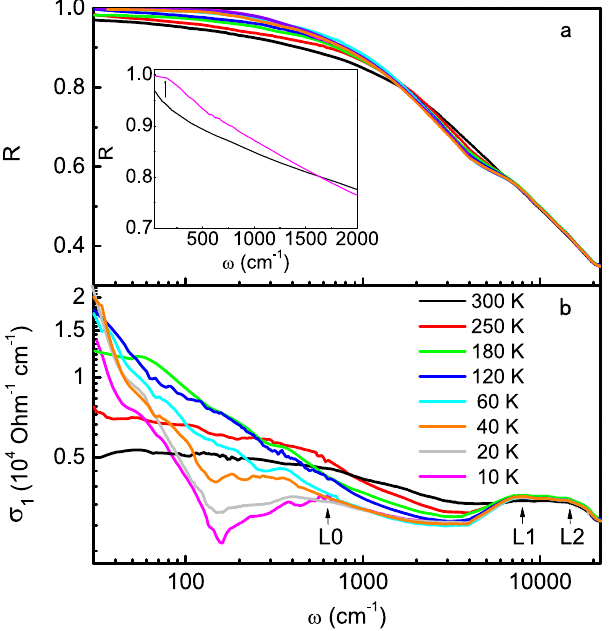
Figure 2. Unpolarized optical reflectivity and conductivity of MnP. ( a ) Temperature dependence of the reflectivity spectra R ( ω ) measured with unpolarized light. The arrow in the inset denotes the low- ω reflectance edge at 10 K. ( b ) Temperature dependence of the real part of the optical conductivity σ 1 ( ω ). The two peaks at high frequencies remain almost unchanged with